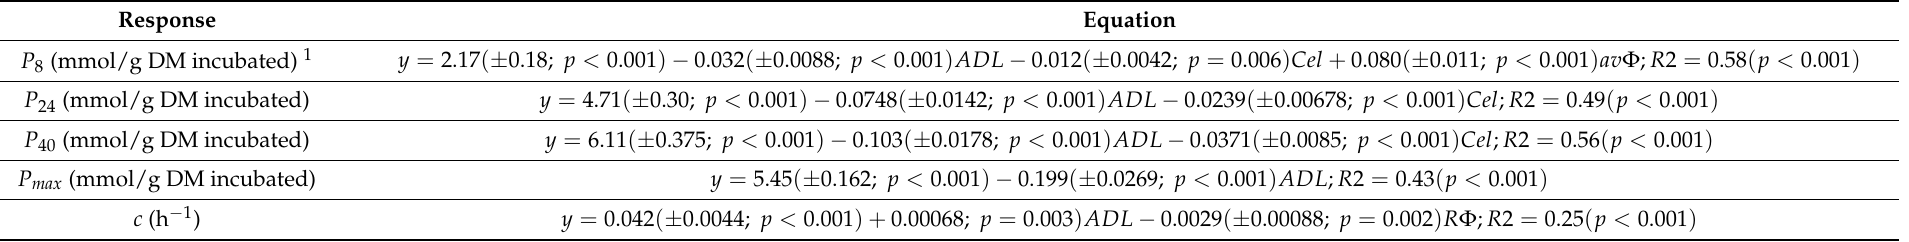
Table 4. Relationships between total gas production at 8, 24, and 40 h of incubation and the theoretically maximum gas production, with proximate composition and morphological variables of straw from three genetic improvement trials (Oats 1, advanced breeding lines and commercial varieties; Oats 2, commercial and historical varieties; Wheat, advanced breeding lines and commercial varieties) incubated in rumen in vitro